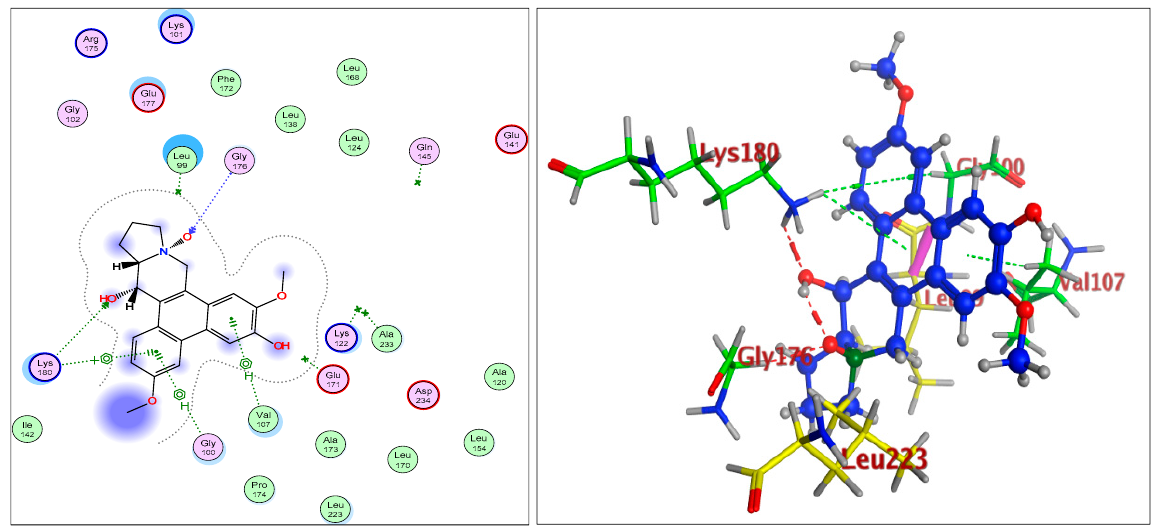
Figure 5. Overlay of compound ( 5 ) bound to the active site of ATP-binding pocket of Aurora-B.